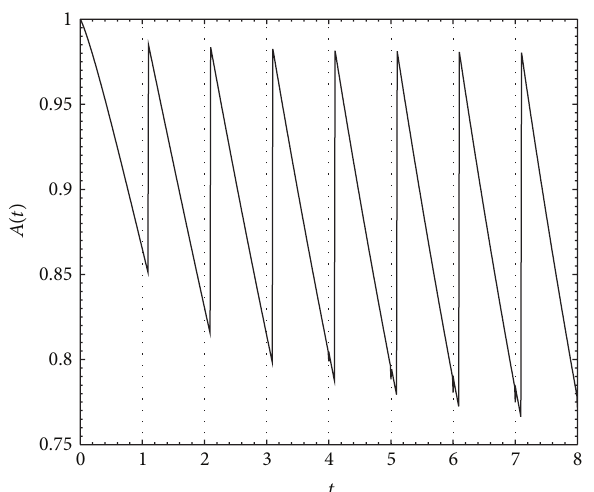
Figure3:TheavailabilitycurveundermodelAwith 𝜏 = 1.0 , 𝑏 = 0.1 , and 𝑚 = 3